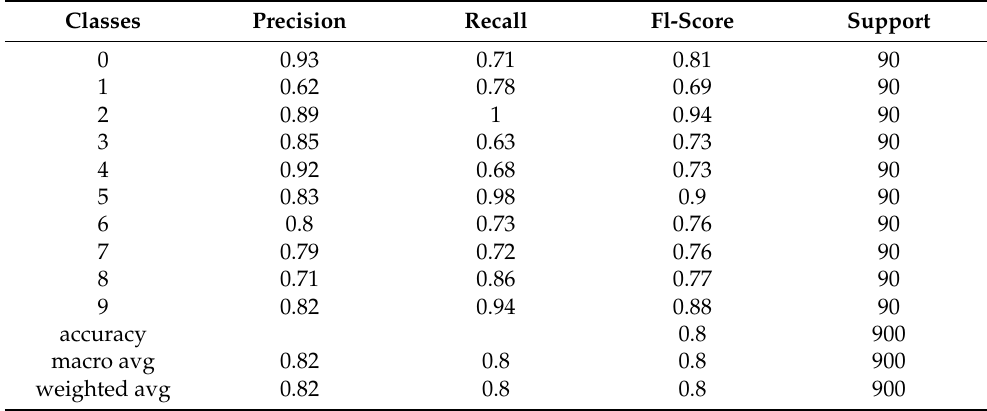
Table 3. Performance metrics in validation.